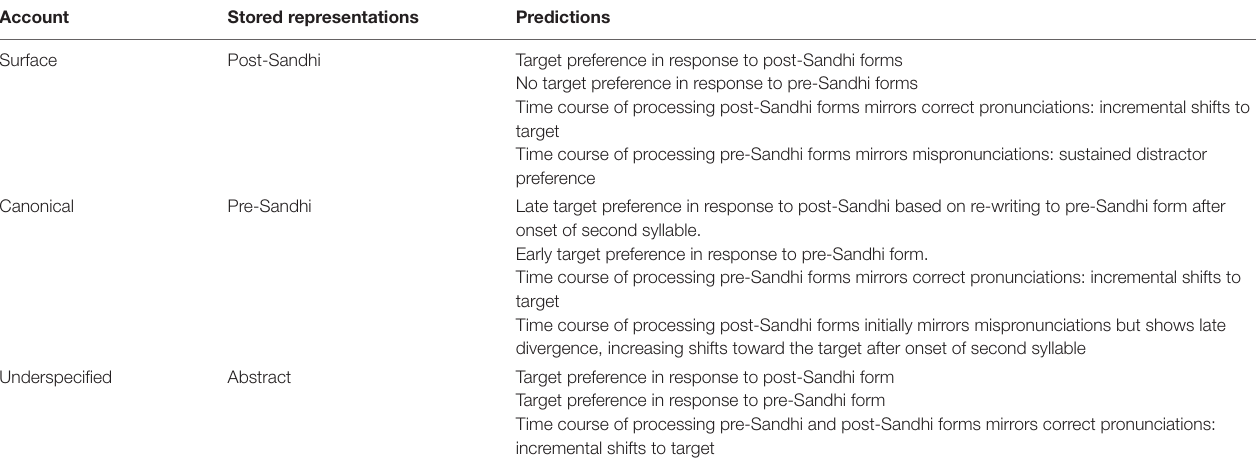
TABLE 1 | Summary of predicted findings for surface, canonical and underspecified